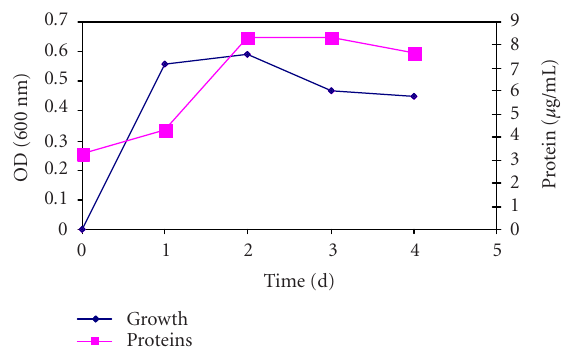
Figure 11. Protein production relative to growth of Pichia pastoris KM71-H (mut s ) .